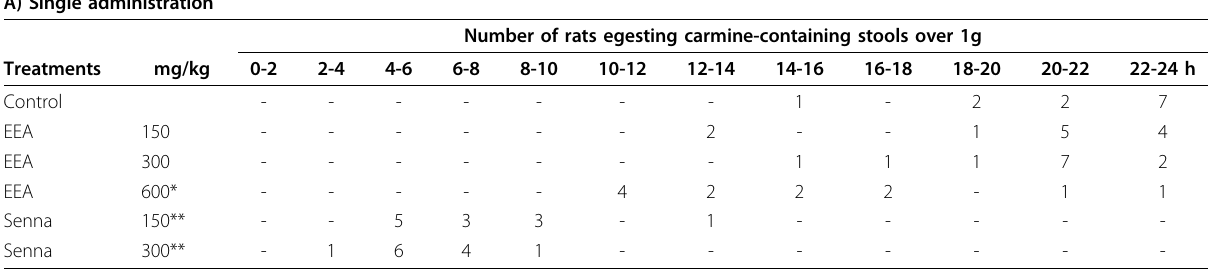
Table 3 Effects of EEA and senna on carmine egestion in a rat model of low-fiber diet-induced constipation A) Single administration